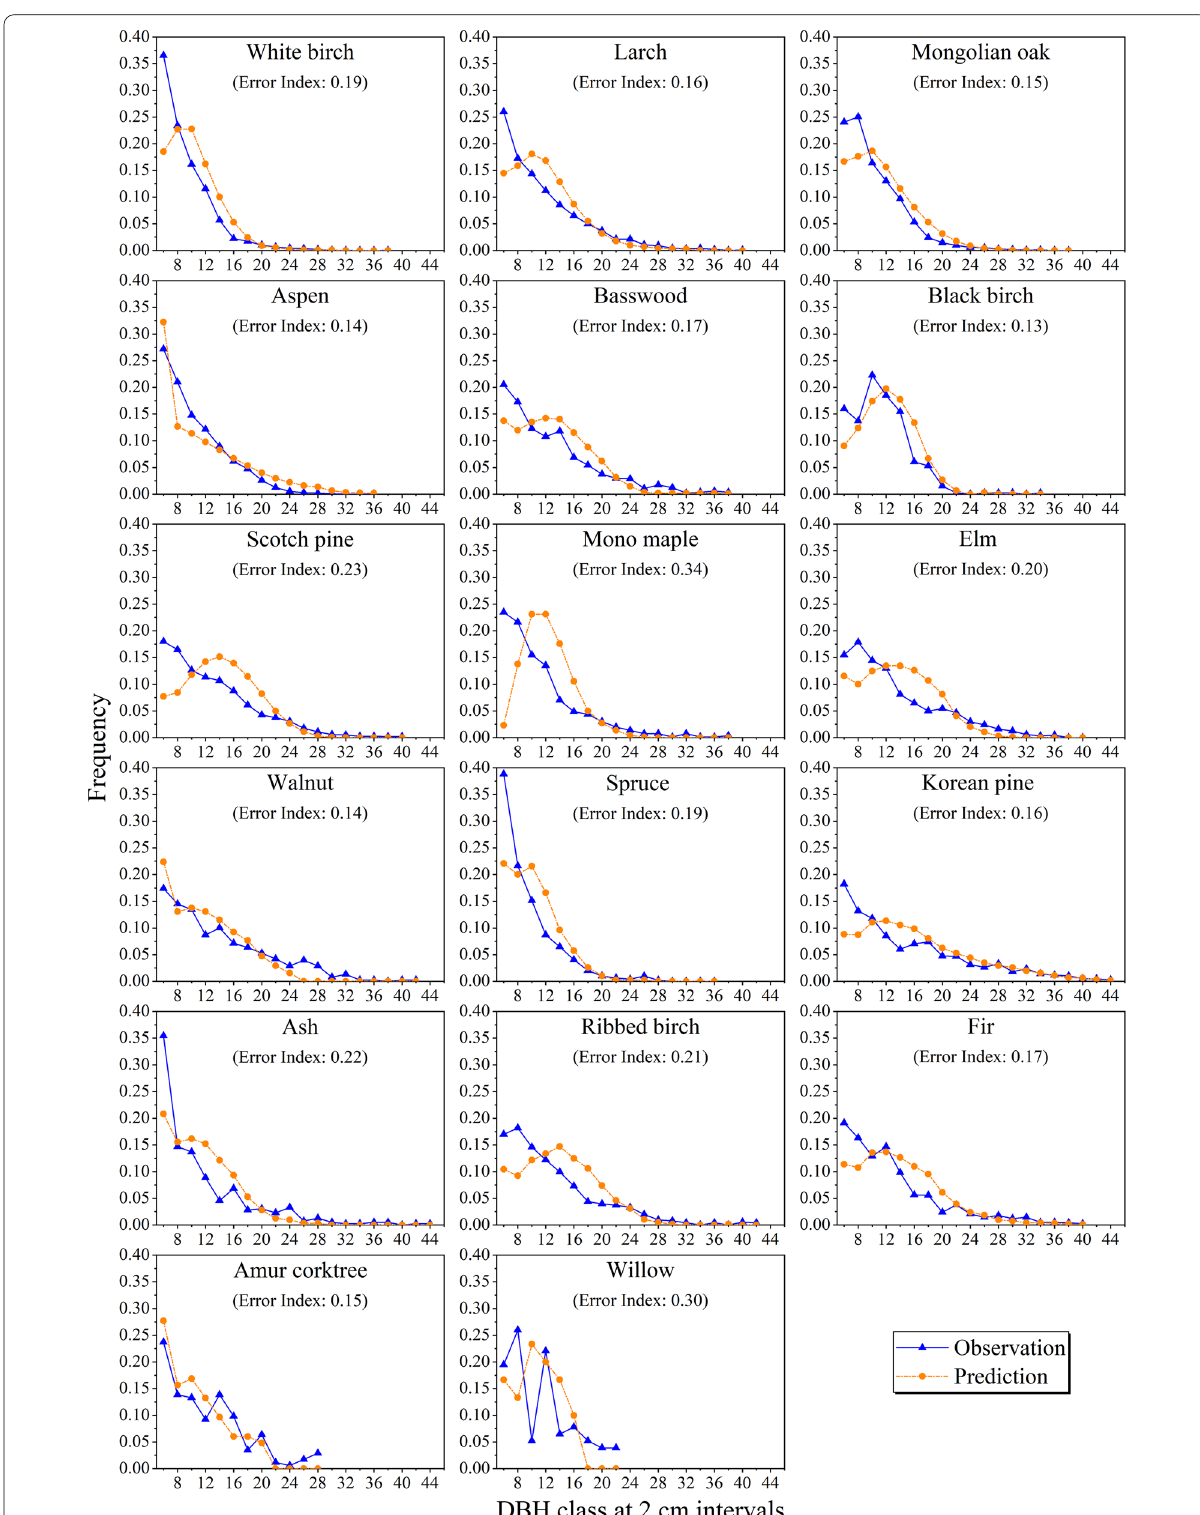
Fig. 7 DBH distribution frequency by species of predicted wall-to-wall tree lists versus observed tree lists in 2000 based on the transformed sample plot data. The error index was calculated by combining all transformed plots as a